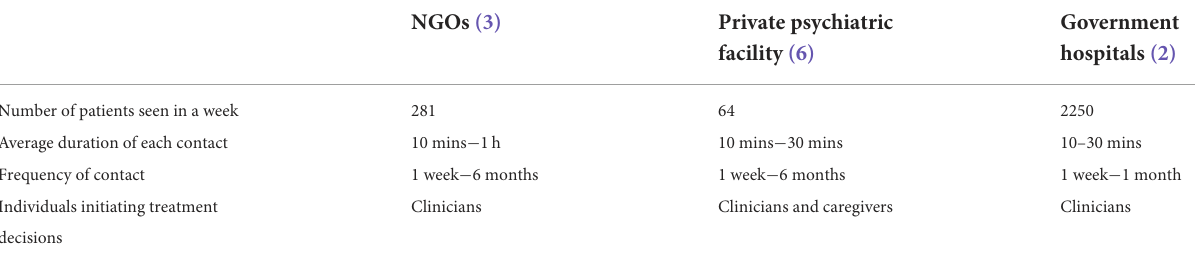
TABLE 3 Description of patient volumes, average duration of contact, frequency of contact, decision making by type of facilities.